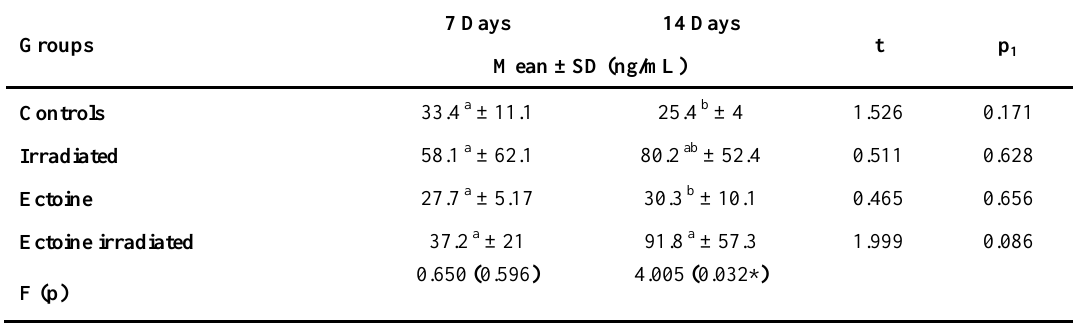
Table 2. The effect of ectoine on serum Cardiac Troponin- T (cTnT) in the model of irradiation-induced cardiotoxicity in female albino mice